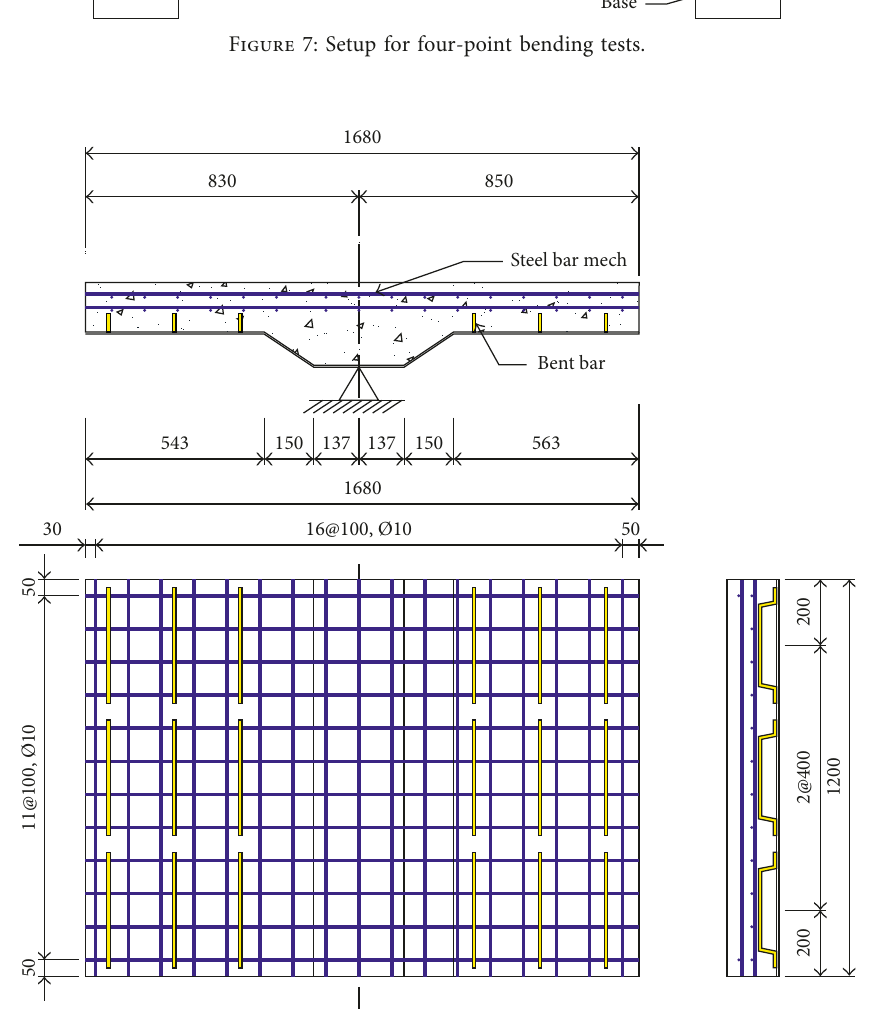
Figure 7: Setup for four-point bending tests.